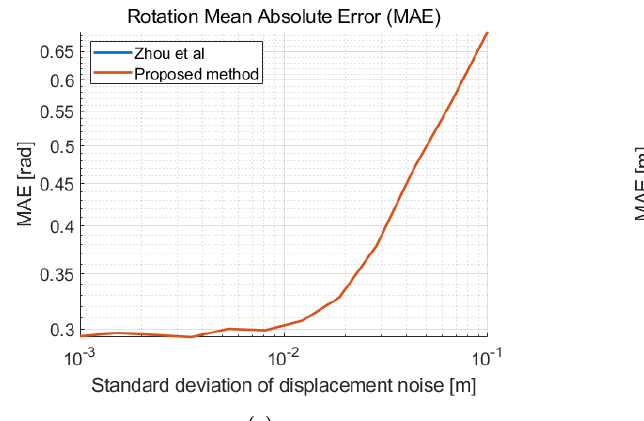
Figure 4. Mean absolute error (MAE) as a function of the standard deviation of the displacement noise σ p and a distance standard deviation σ d = 2cm. ( a ) MAE of the rotation with respect to the ground truth. ( b ) MAE of the translation with respect to the ground truth.